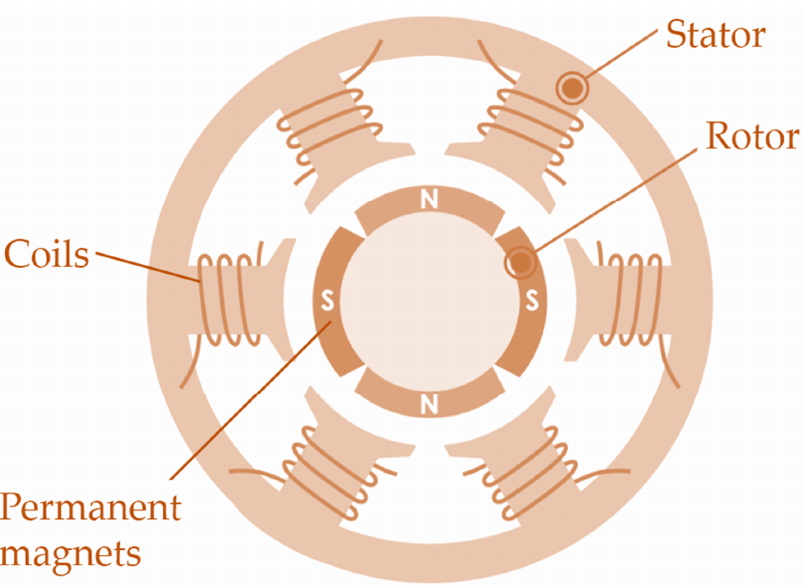
Figure 6. Rotor and stator of the brushless direct current motor.